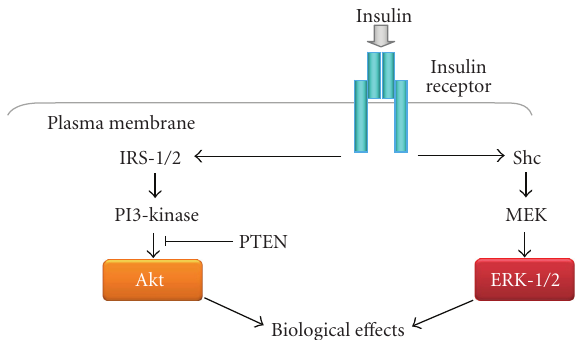
Figure 2: Insulin signaling pathway in adipose cells. Binding of insulin to its tyrosine kinase receptor engages a cascade of intracellular phosphorylation events, including activation of phosphatidylinositol-3-kinase and ERK-1/2, that promote multiple biological responses, including glucose uptake, lipid metabolism, survival, di ff erentiation, and modulation of gene